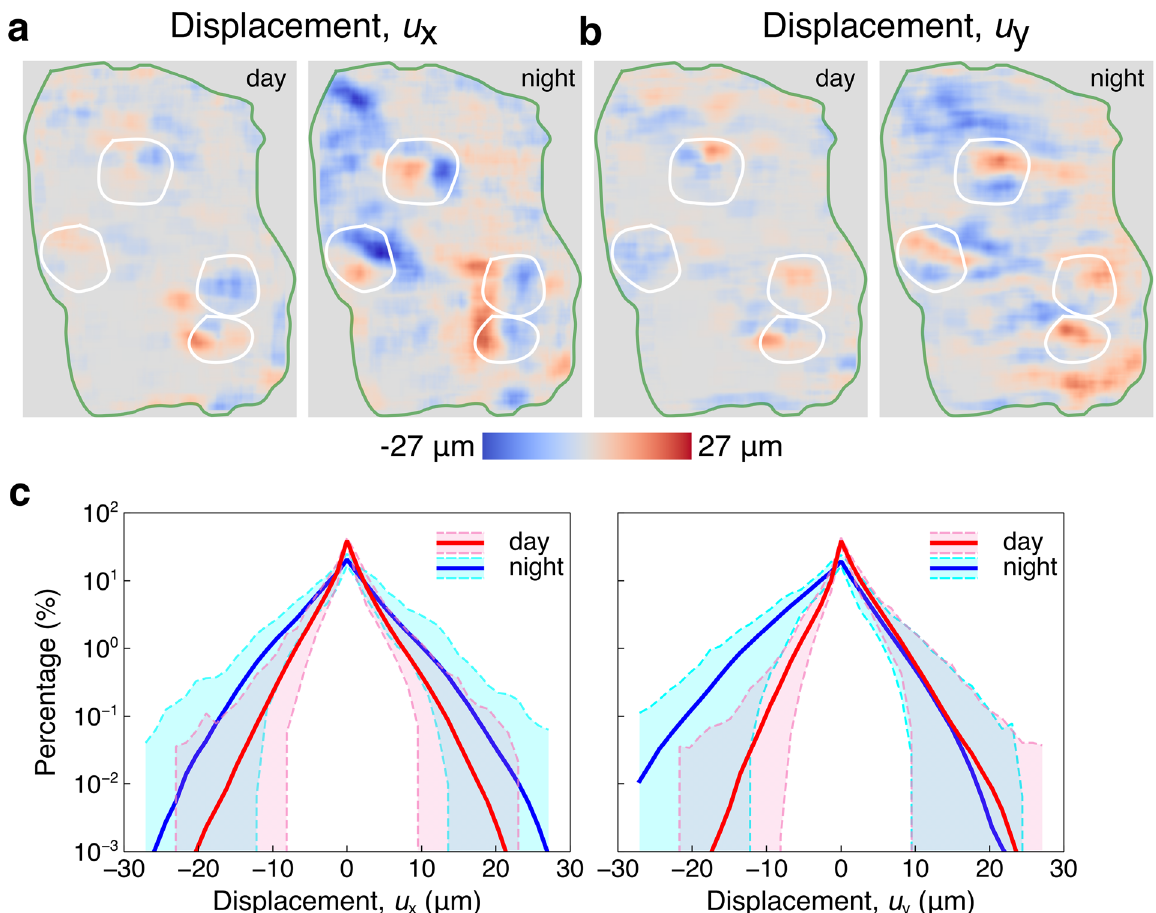
Figure 2. Displacements of the coral tissue surface from digital image correlation. ( a ) The displacements u x along horizontal direction between the reference picture and the second picture at day and night are shown in the left and right panel, respectively. ( b ) The displacement u y along vertical direction between the reference picture and the second picture at day and night are shown in the left and right panel, respectively. Green curves in ( a ) and ( b ) represents the edge of the fragment and white curves enclose the polyps. ( c ) The percentage histograms of displacement u x and displacement u y are shown in the left and right panels, respectively. The red and blue curves indicate the means of each displacement during day and night. The pink and cyan regions are variations during day and night, Supplementary Fig. 2) was smaller in the blue light at night than at day. Besides, the hue is more blueish at night due to the lack of the ceiling light. Visualization of coral dynamic motion, not perceptible by the human eye, can be observed from the time-lapse video played at 10 frames per second (× 1200 speed; Supplementary movie 1). Characterization by digital image correlation. In order to quantify coral tissue motion from a biome- chanics perspective, we used a DIC technique to characterize the deformation of the surface relative to an initial reference picture (the first picture). Displacements ( u x ) along the horizontal direction between the reference picture and the second picture at day and night are shown in Fig. 2a, respectively. The strongest motions are concentrated around polyps and the edge of the fragment. At night, most of the coral tissues surface undergoes horizontal motion, while few coral tissues are moving horizontally at day. Displacements ( u y ) along the vertical direction were also quantified between the reference picture and the second picture at day and night, respectively (Fig. 2b). Similar to the distribution of displacement u x , the strongest motions are concentrated around polyps and the edge of the fragment. Vertical tissue motion is more widespread across the coral at night compared to daytime. The displacement of both u x and u y , in comparison to the reference picture between day and night, can be seen in videos created from two hundred pictures (Supplementary movie 2 and Supplementary movie 3). These visualizations highlight that the coral tissue surface is moving dynamically over time, with more move- ment observed during the night than during the day. In order to explore the statistics of DIC results, we show the histogram of displacements u x and u y . Across ~ 13 h, histograms of displacements u x and u y are continuously changing (Supplementary movie 4). Figure 2c exhibits the percentage histograms of the displacement u x and u y during day and night in the left and right panels. The red and blue curves in each panel indicate the mean of displacement distribution during day